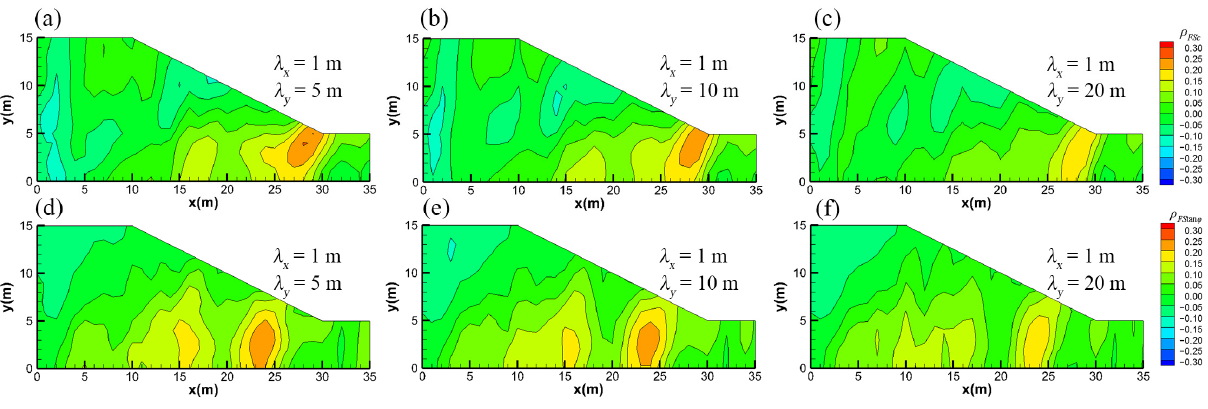
Figure 7. Cross-correlation maps of FS and c ( a – c ) and tan ϕ ( d – f ) under three different vertical Figure 7. Cross ‐ correlation maps of FS and c ( a – c ) and tan φ ( d – f ) under three different vertical sta ‐ statistical anisotropic correlation tistical anisotropic correlation scales.